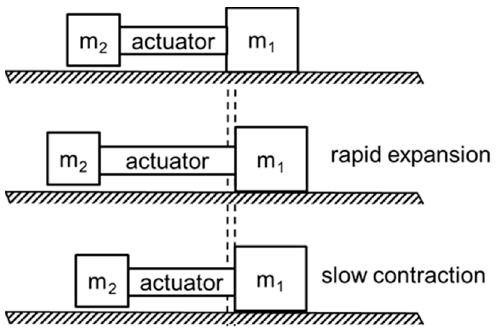
Figure 4. Inertia-drive piezoelectric motor proposed by Higuchi in 1986 [30].